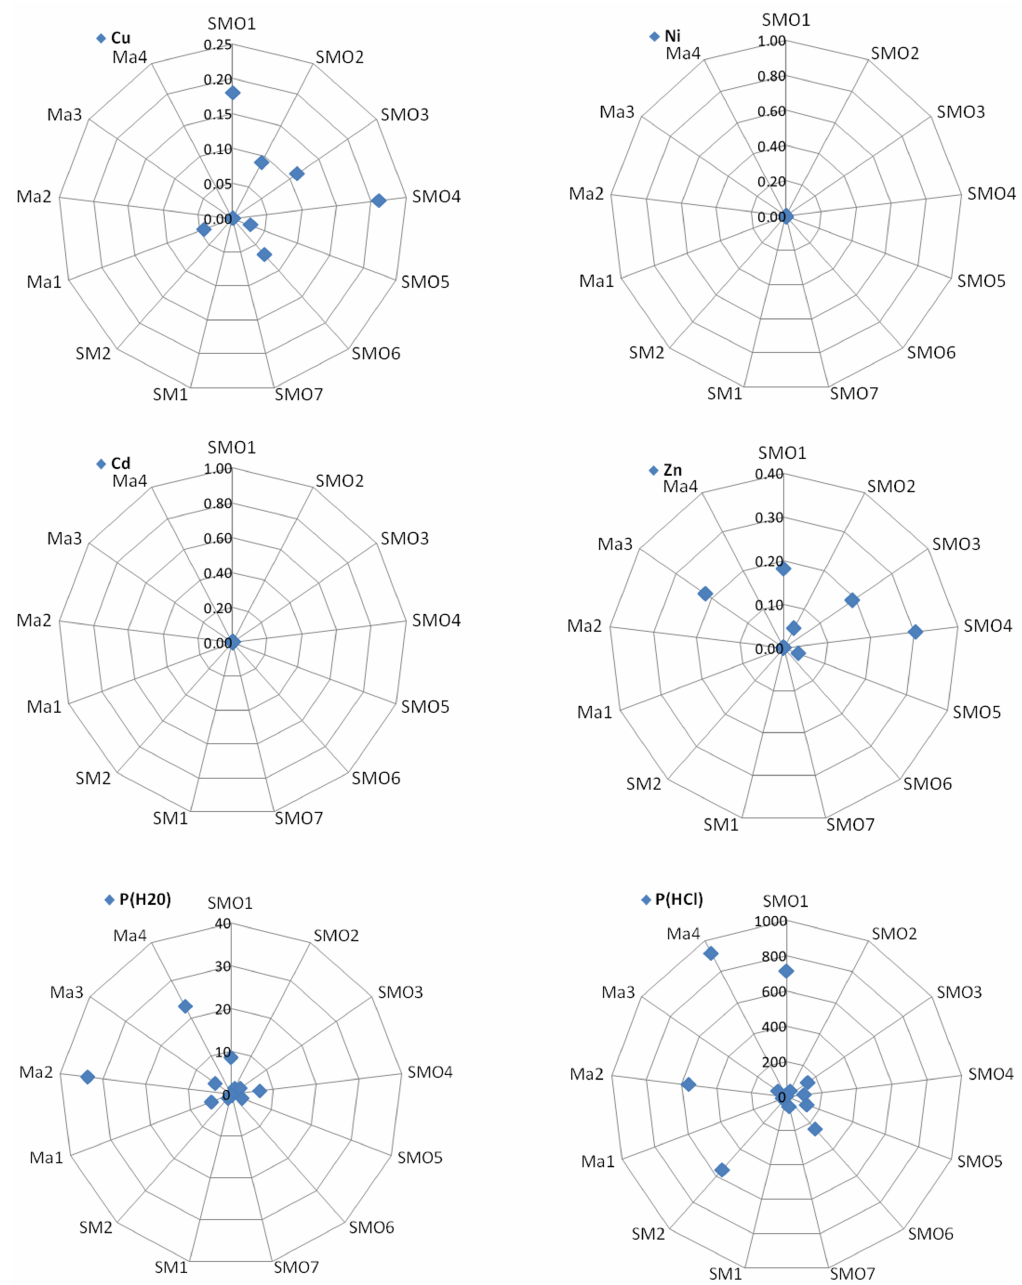
Figure 3. Metals and phosphorus content in tested green roof substrates (mg/kg).